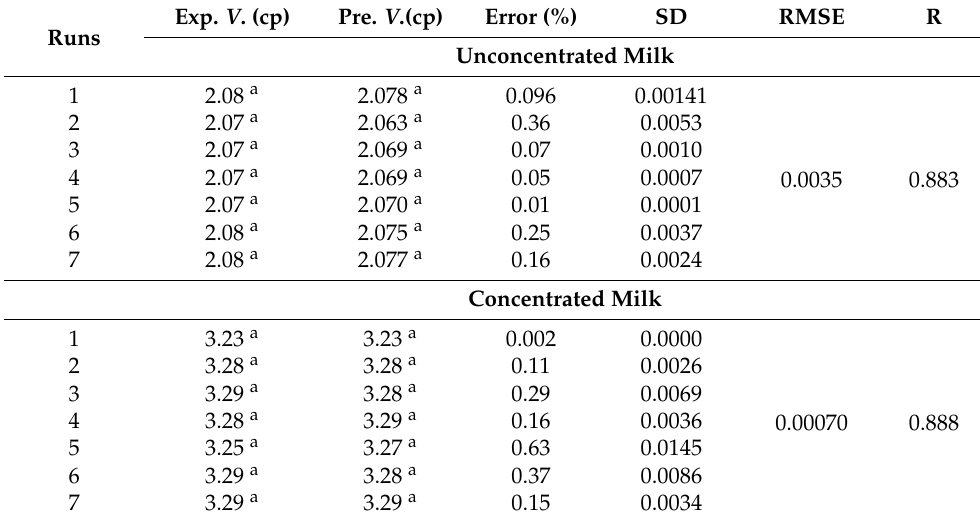
Table 5. Statistical parameters of experimental and predicted unconcentrated milk viscosity values affected by color components. Exp. V . (cp) Pre. V .(cp) Error Runs